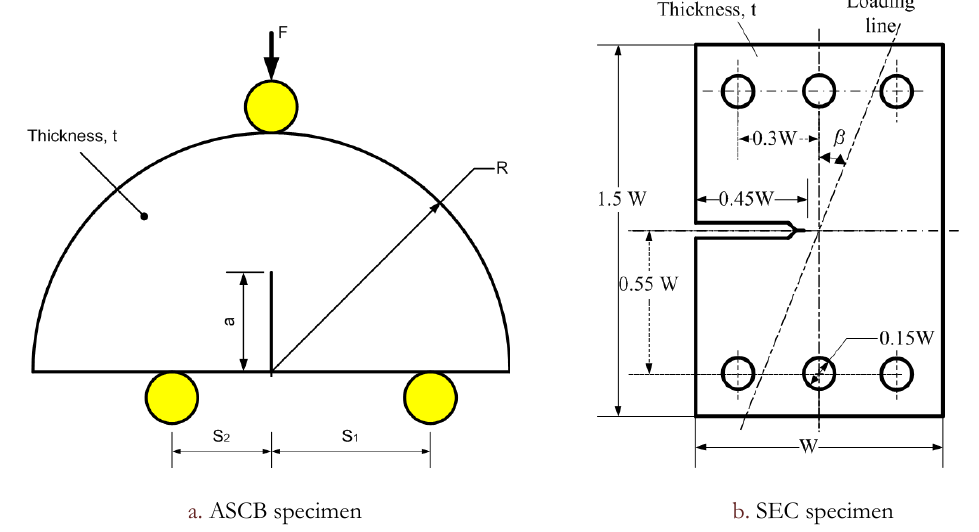
Figure 1: Specimens used from fracture toughness and mixed mode loading